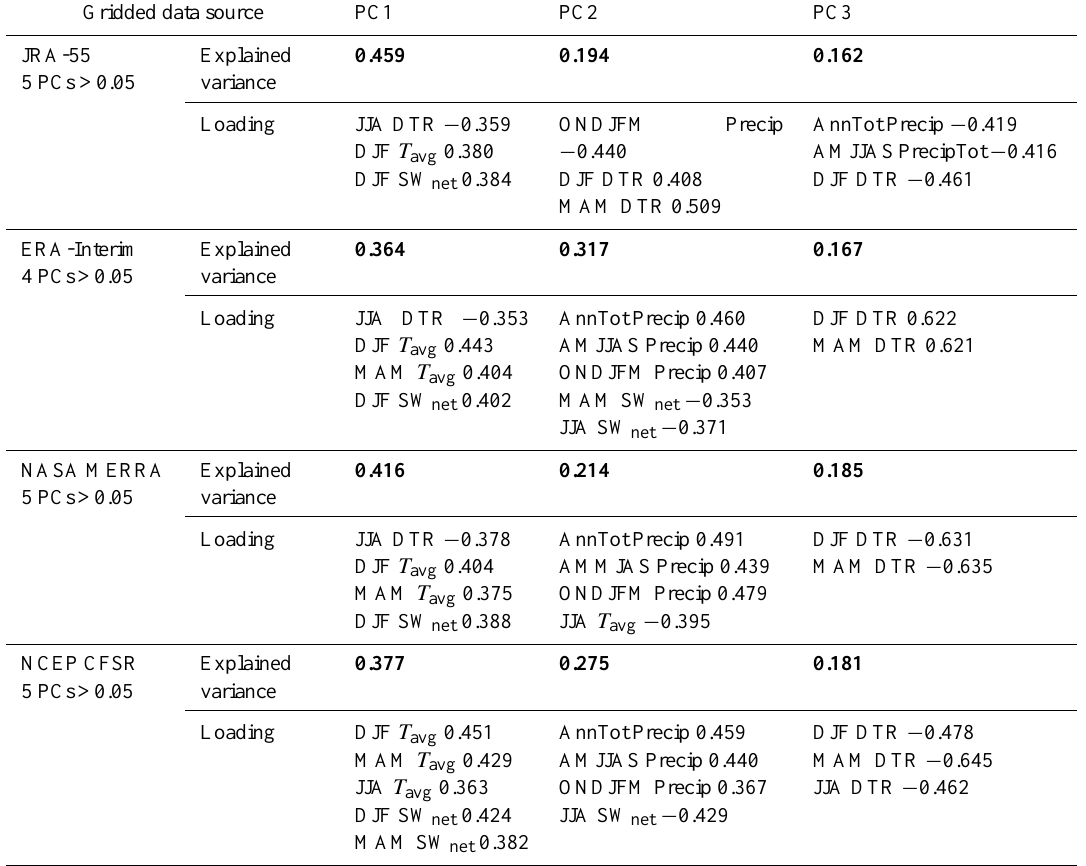
NB: rows labelled “Explained variance” indicate fraction of total input variance accounted for by the principal component (PC). Rows labelled “Loading” indicate input variables whose (coefficient) contribution to the PC is >0.35. Loading coefficients are shown with their signs to differentiate between variables with opposing